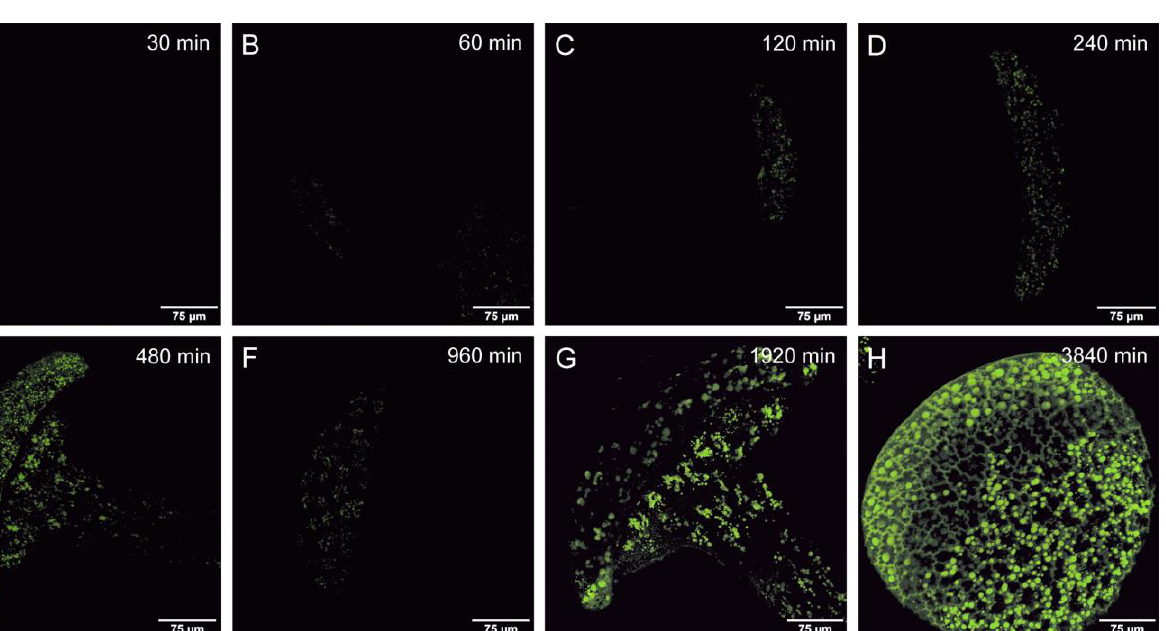
Simultaneous to the decreasing vesicle number, an increase in vesicle diameter over